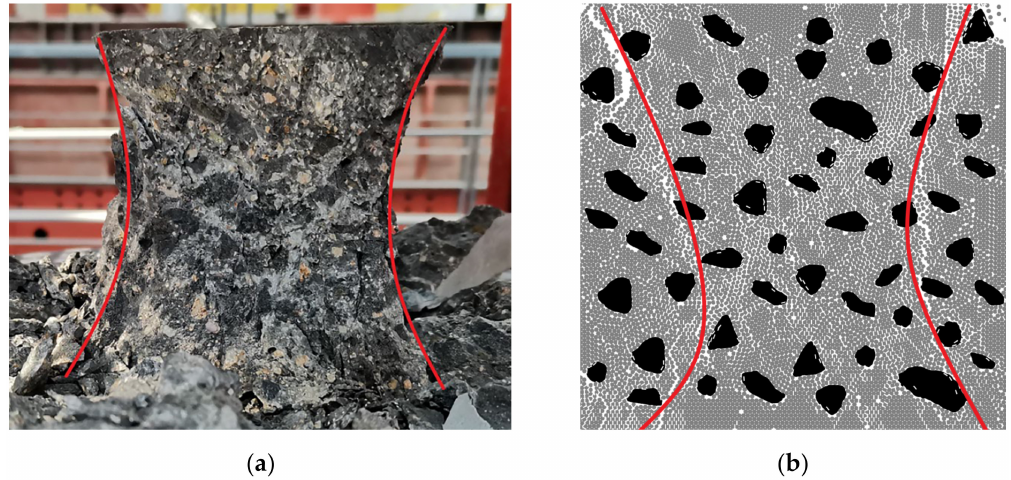
Figure 10. Concrete damage and failure forms: ( a ) experimental; ( b ) numerical simulation.